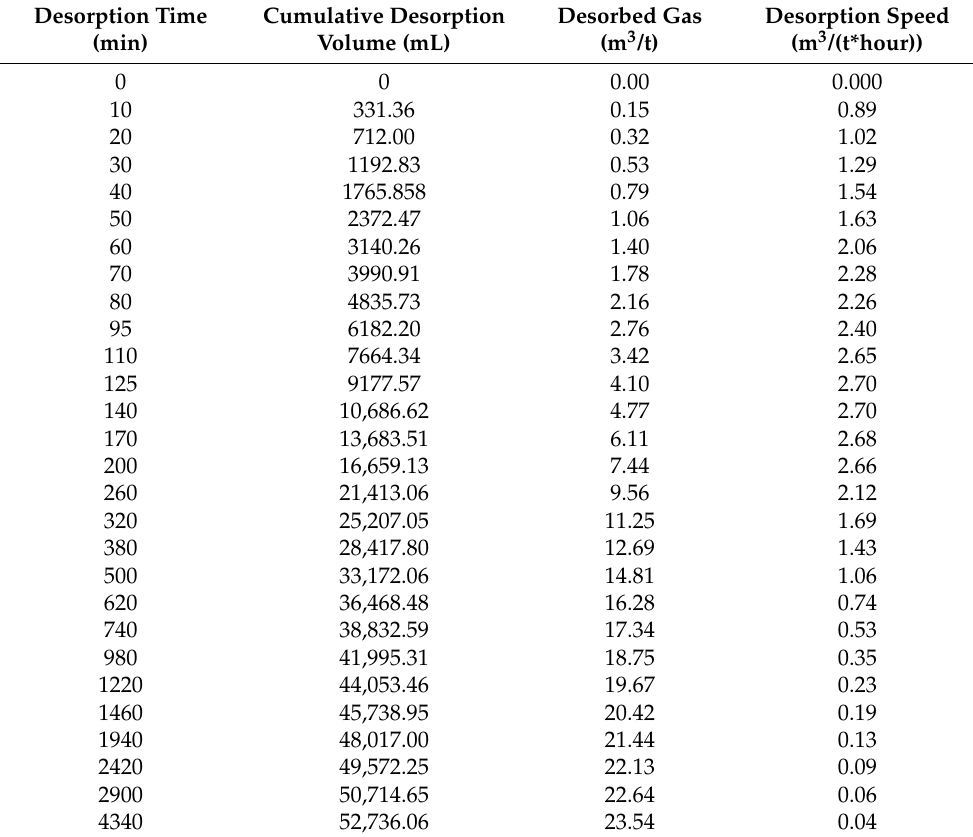
Table 2. Desorption Data